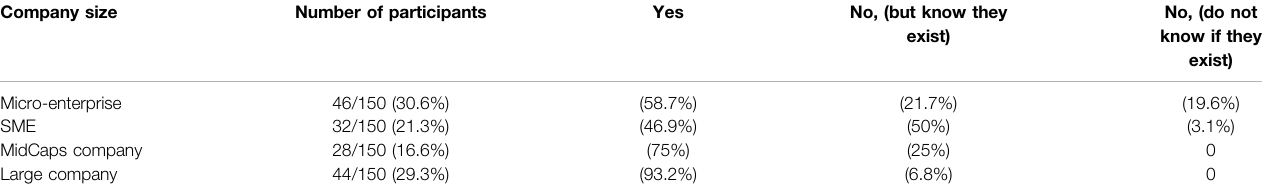
TABLE 12 | Correlation between the awareness of security mechanisms and the size of the company. Company size Number of participants